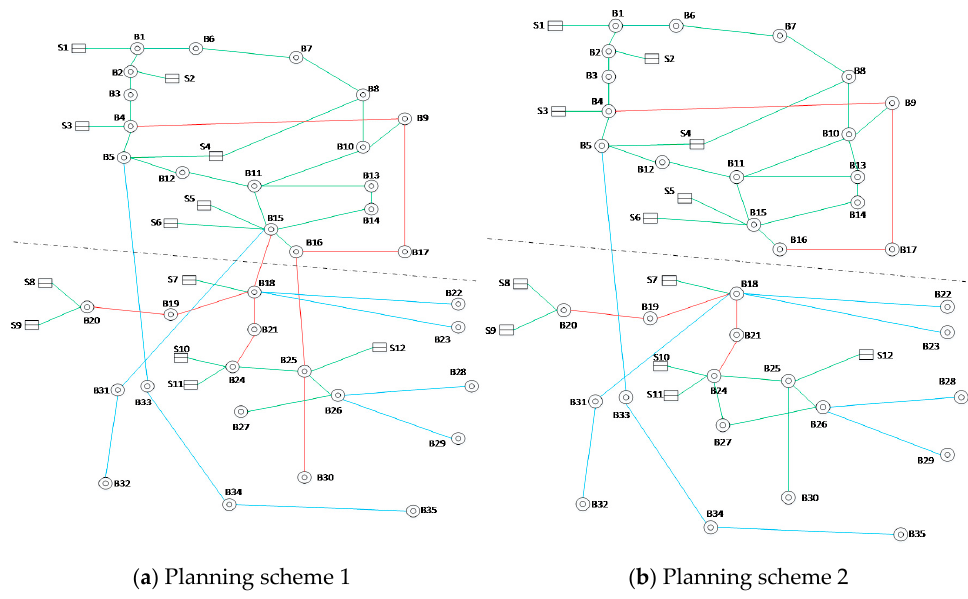
Figure 6. Planning scheme for a regional grid. ( a ) Planning scheme 1; ( b ) Planning scheme